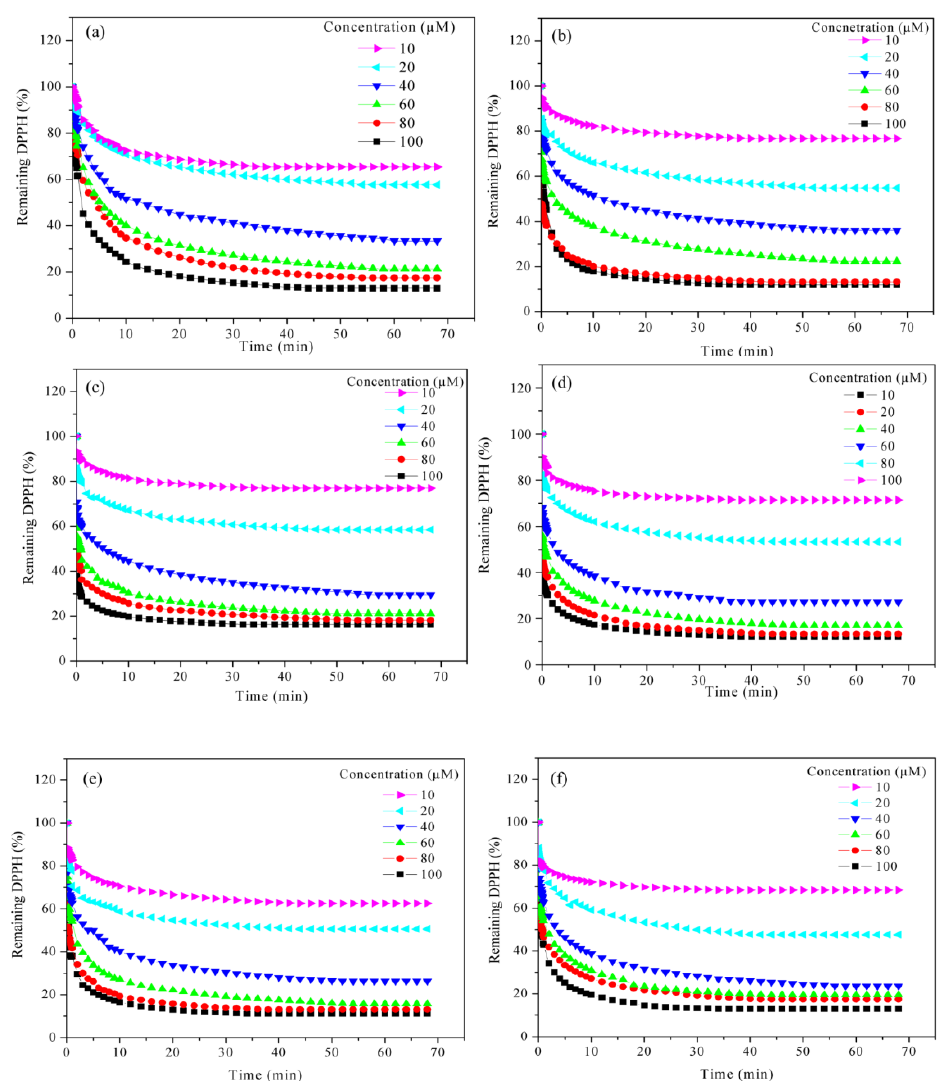
Figure 1. Reaction kinetic between 60 µM of DPPH• and different concentration FA and synthesized PILs: ( a ) FA; ( b ) 2MAEF; ( c ) 2PAEF; ( d ) 2BAEF; ( e ) 3DMAPF; ( f ) 3DEAPF.